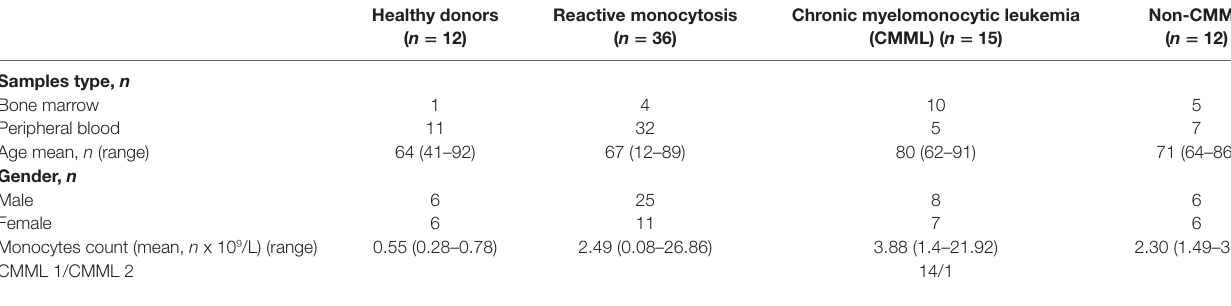
TaBle 1 | Patients